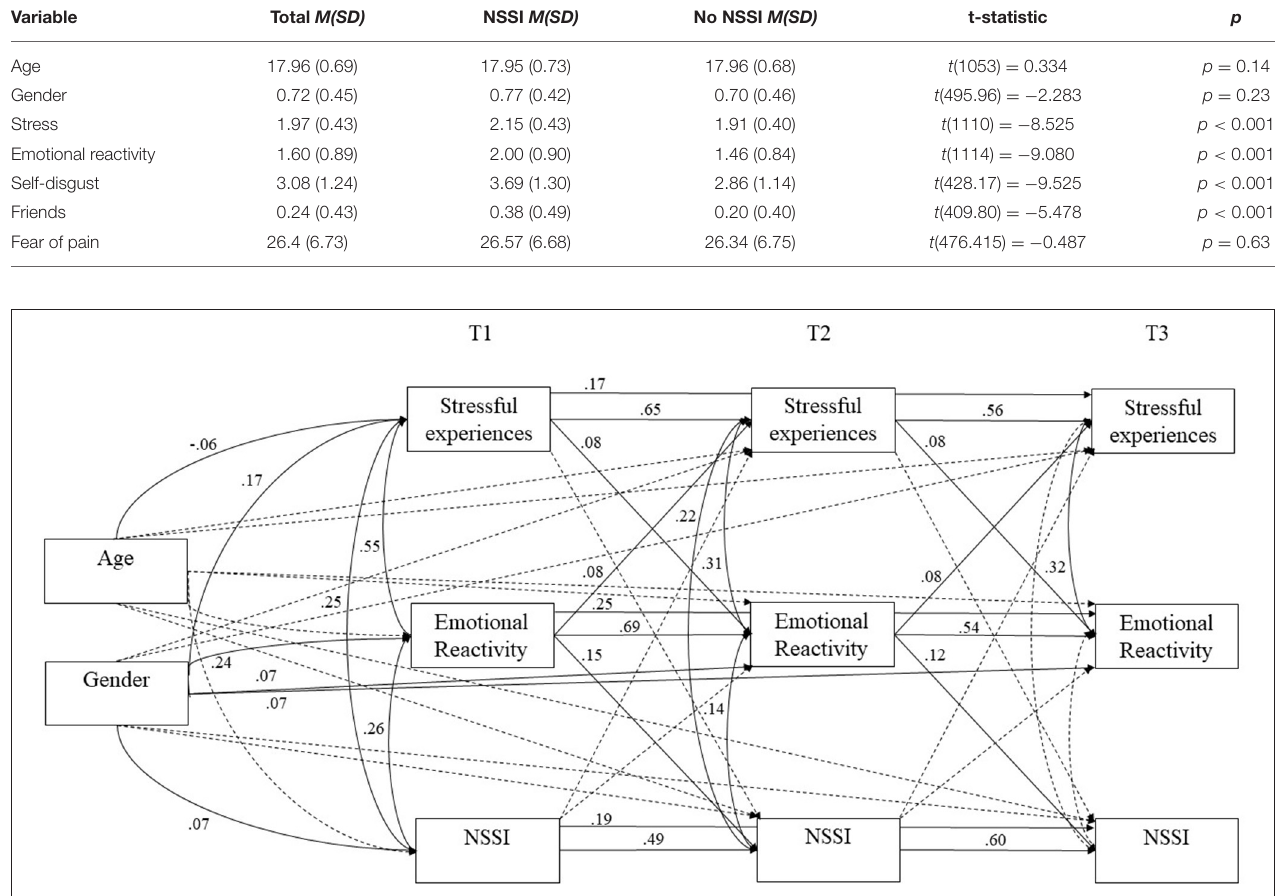
FIGURE 1 | Path analysis model. T1 denotes Time 1, T2 denotes Time 2, and T3 denotes Time 3. All paths tested are included in the model; dotted lines denote non-significant paths, solid lines denote significant paths.